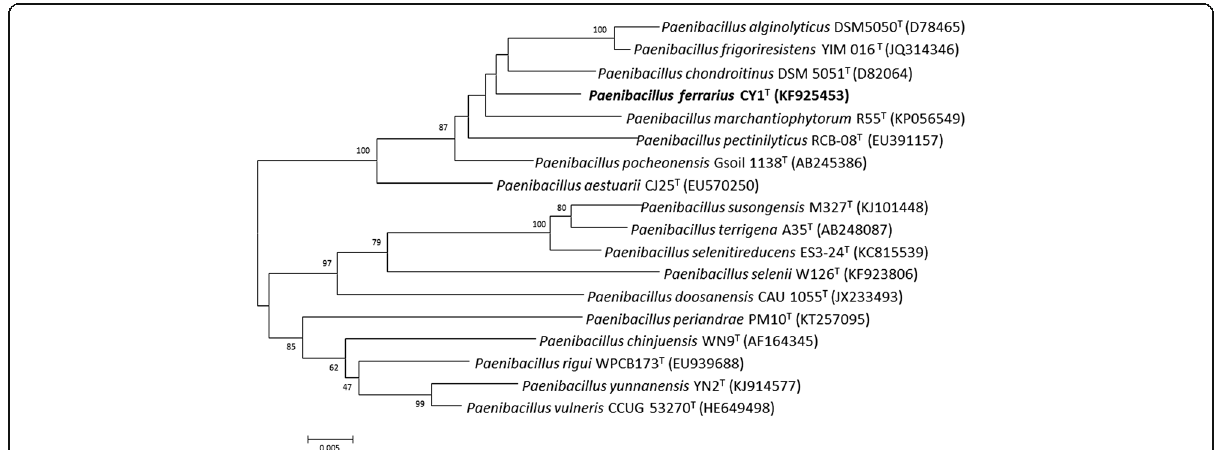
Fig. 2 Phylogenetic tree depicting the relationship between P. ferrarius CY1 T and other members of the genus Paenibacillus . The phylogenetic tree was constructed based on the 16S rRNA gene sequences using neighbor-joining method (MEGA 6.0). The scale bar represents 0.01 nucleotide change per nucleotide